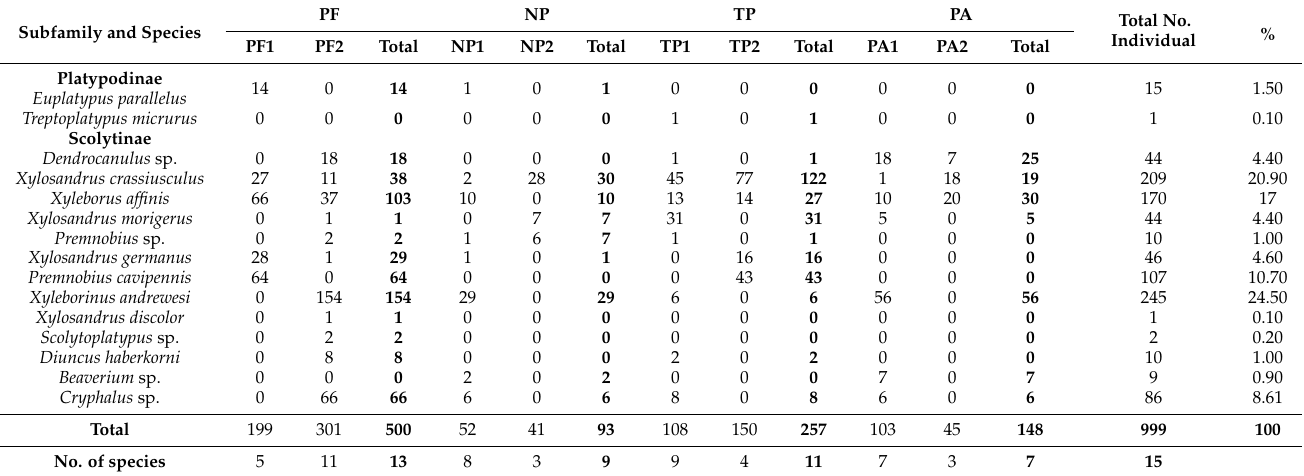
Table 2. Total number of ambrosia beetles and their relative abundance (%) collected from different pine forest types in East Java,